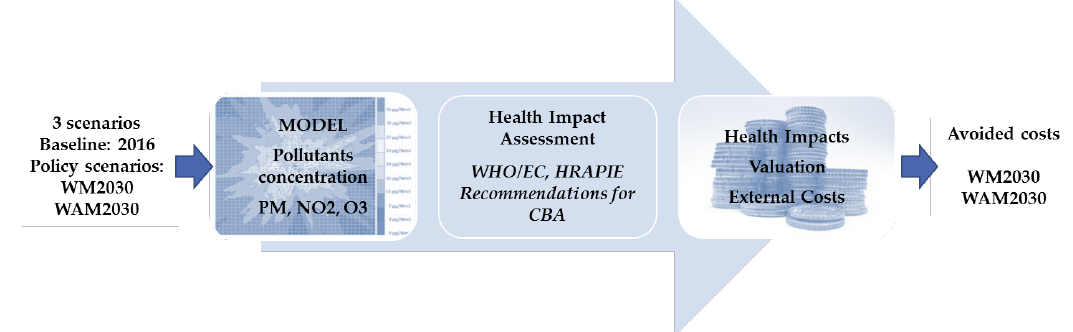
Figure 1. Scheme of the impact pathway approach for external cost calculations associated with the health impacts in the frame of cost–benefit analysis (CBA) of the policy scenarios (with measures: WM2030; and with additional measures: WAM2030). EC: European Commission; WHO: World Health Organization; HRAPIE: Health Risks of Air Pollution in Europe Project.